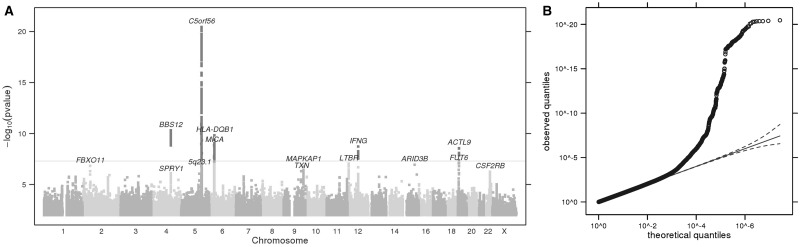
(A) Manhattan plot of GWS loci for itch intensity from mosquito bites, adjusted for bite size and excluding responders positive for common immune-related conditions. The grey horizontal line corresponds to P = 5 × 10−8, and results above this threshold are shown in dark grey. Gene labels are annotated as the nearby genes to the significant SNPs. λ = 1.042. (B) Quantile-quantile plot (insert). Observed P values versus theoretical P values under the null hypothesis of no association, plotted on a log scale. The solid black line is shown with a slope of 1, and dashed black lines represent a 95% confidence envelope under the assumption that the test results are independent.